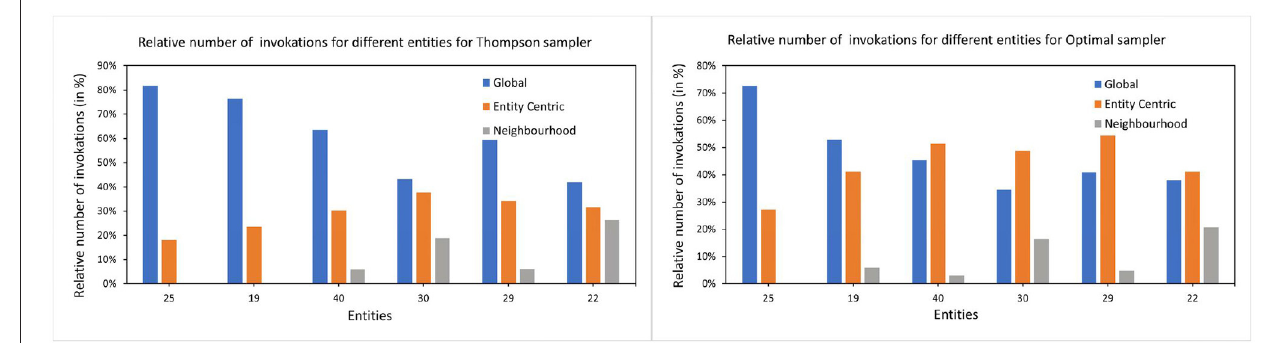
FIGURE 8 | The relative number of invocations for global and local arms. The left subfigure shows the number of times each arm is invoked for all the items by TS samplers for selected entities. Y -axis shows the relative number of invocations and the X -axis are the entities. The right subfigure shows the same for the optimal sampler. For demonstration purposes, we have chosen 6 entities with varying history lengths.